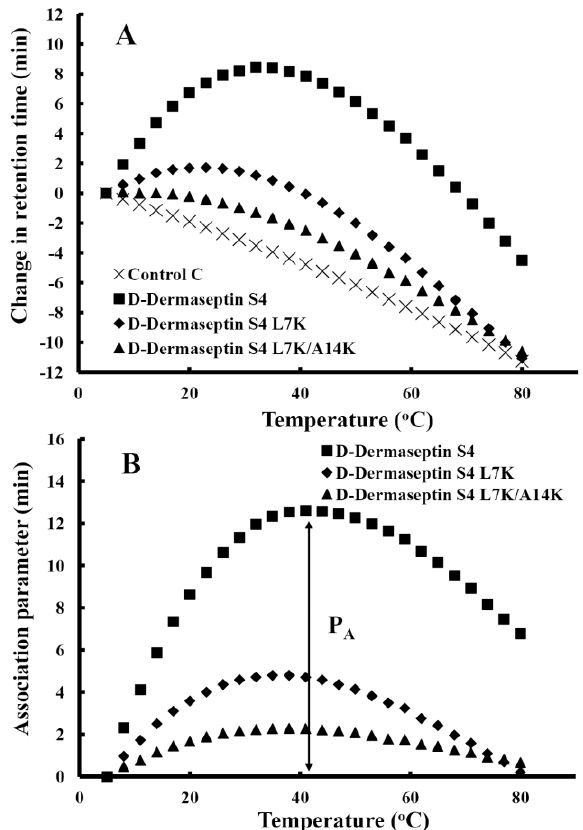
Figure 6. D -dermaseptin S4 analogs self-association ability as monitored by temperature profiling in RP-HPLC. In panel A , the retention times of peptides are normalized to 5 °C through the expression (t Rt –t R5 ), where t Rt is the retention time at a specific temperature of an antimicrobial peptide or control peptide C, and t R5 is the retention time at 5 °C. In panel B , the retention behavior of the peptides was normalized to that of control peptide C through the expression (t Rt –t R5 for peptides)–(t Rt –t R5 for control peptide C). The maximum change in retention time from the control peptide C defines the peptide association parameter, denoted P (Table 2). The sequences of the peptides and the random coil A control peptide are shown in Table